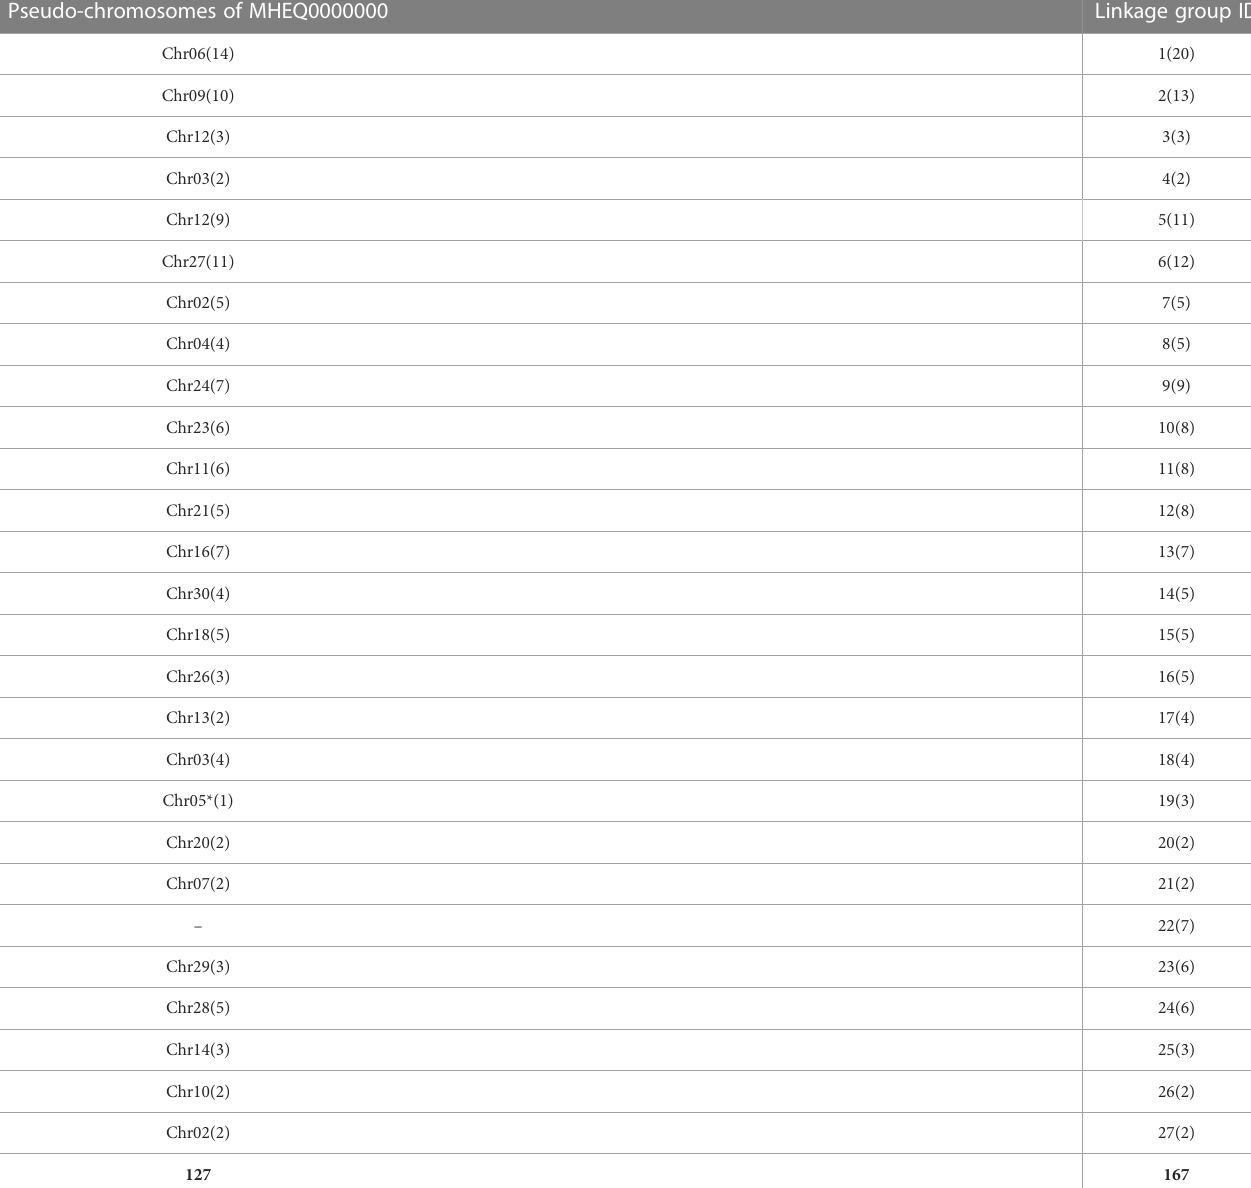
Pseudo-chromosomes of